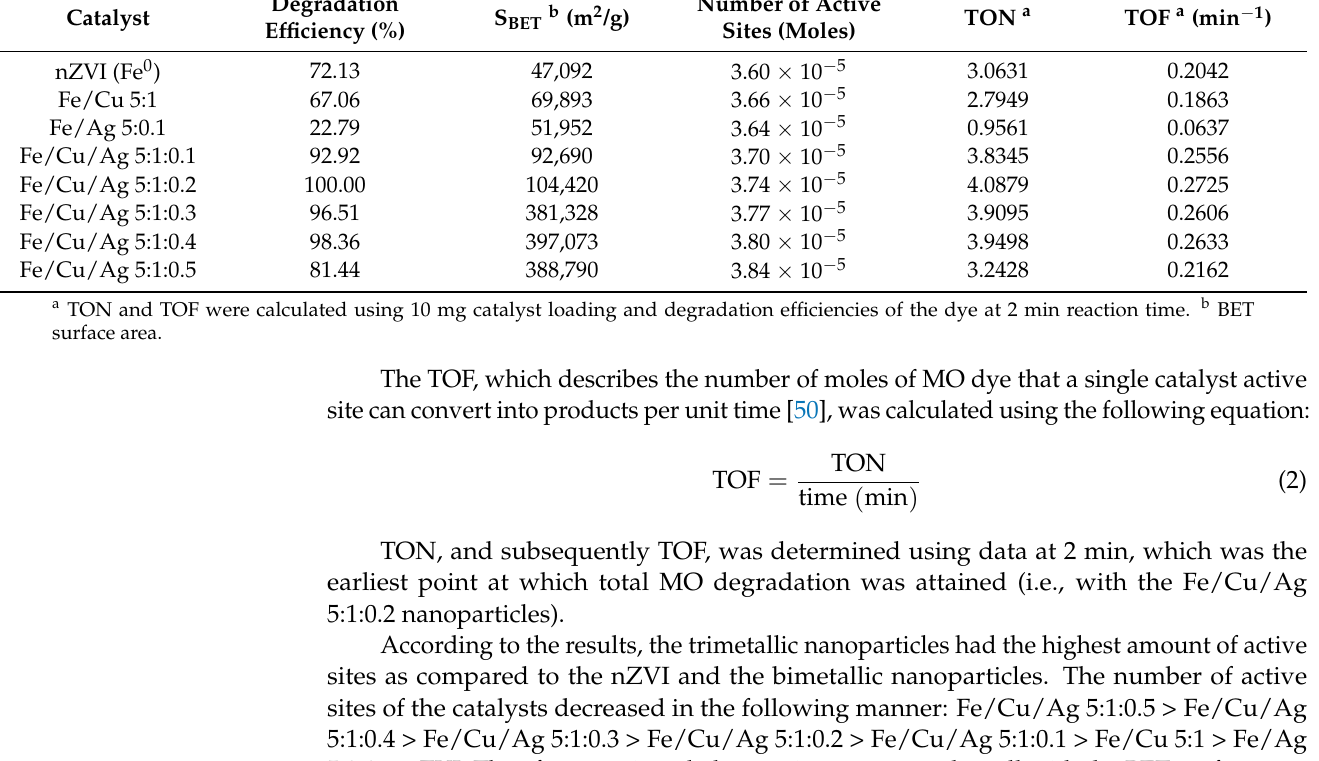
Table 2. The surface area, active sites and catalyst efficiency measures of the prepared nanoparticles.